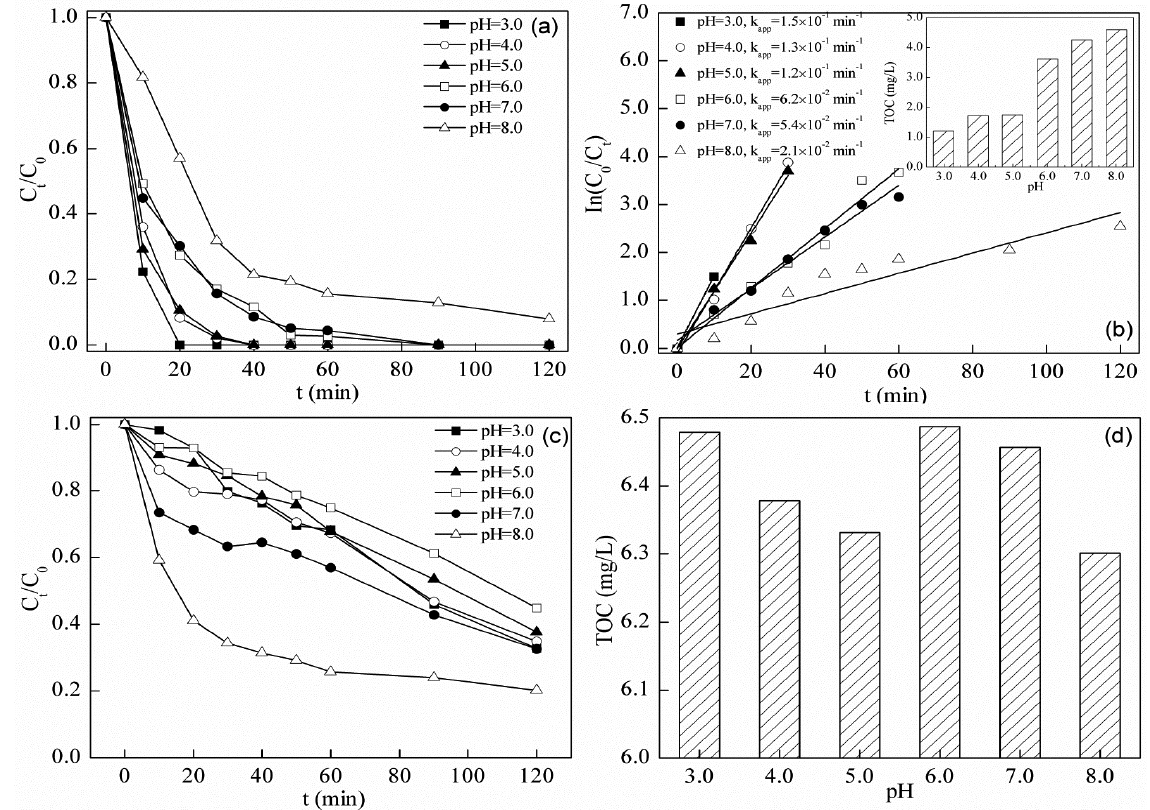
Figure 6. ( a ) Degradation; ( b ) removal kinetics and residual TOC (inset) of TC in the BFO-catalyzed photo-Fenton system at different pH values (initial TC concentration = 10.0 mg/L, initial BFO concentration = 0.5 g/L, initial H 2 O 2 concentration = 0.5 mM); ( c ) Degradation and ( d ) residual TOC concentration of TC with H 2 O 2 at different pH values (initial TC concentration = 10.0 mg/L, initial H 2 O 2 concentration = 0.5 mM, time = 120 min). Table 1. The apparent rate constants ( k app ) and residual TOC concentration for photocatalysis, the Fenton process under the optimum pH condition and for the photo-Fenton process in a pH range 3.0 to 6.0.